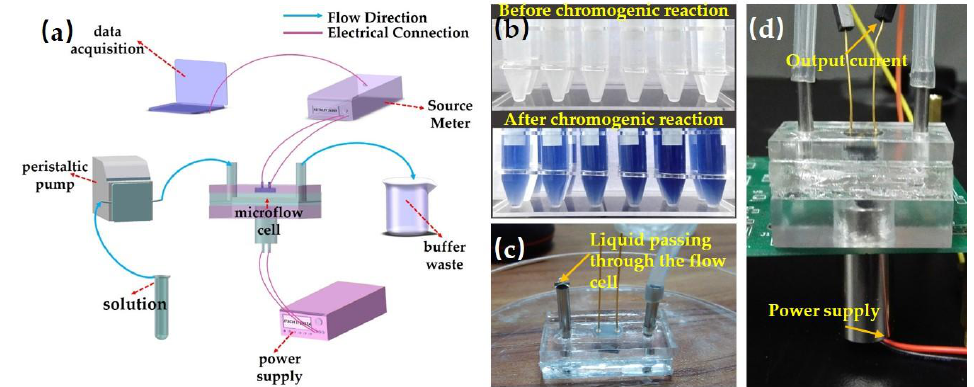
Figure 4. ( a ) The schematics of the experimental setup for photometric detection. ( b ) Solutions to be tested after chromogenic reaction. ( c ) The circulating validation of micro flow cell. ( d ) shows the inlet connected with a peristaltic pump and tested with applied voltages.